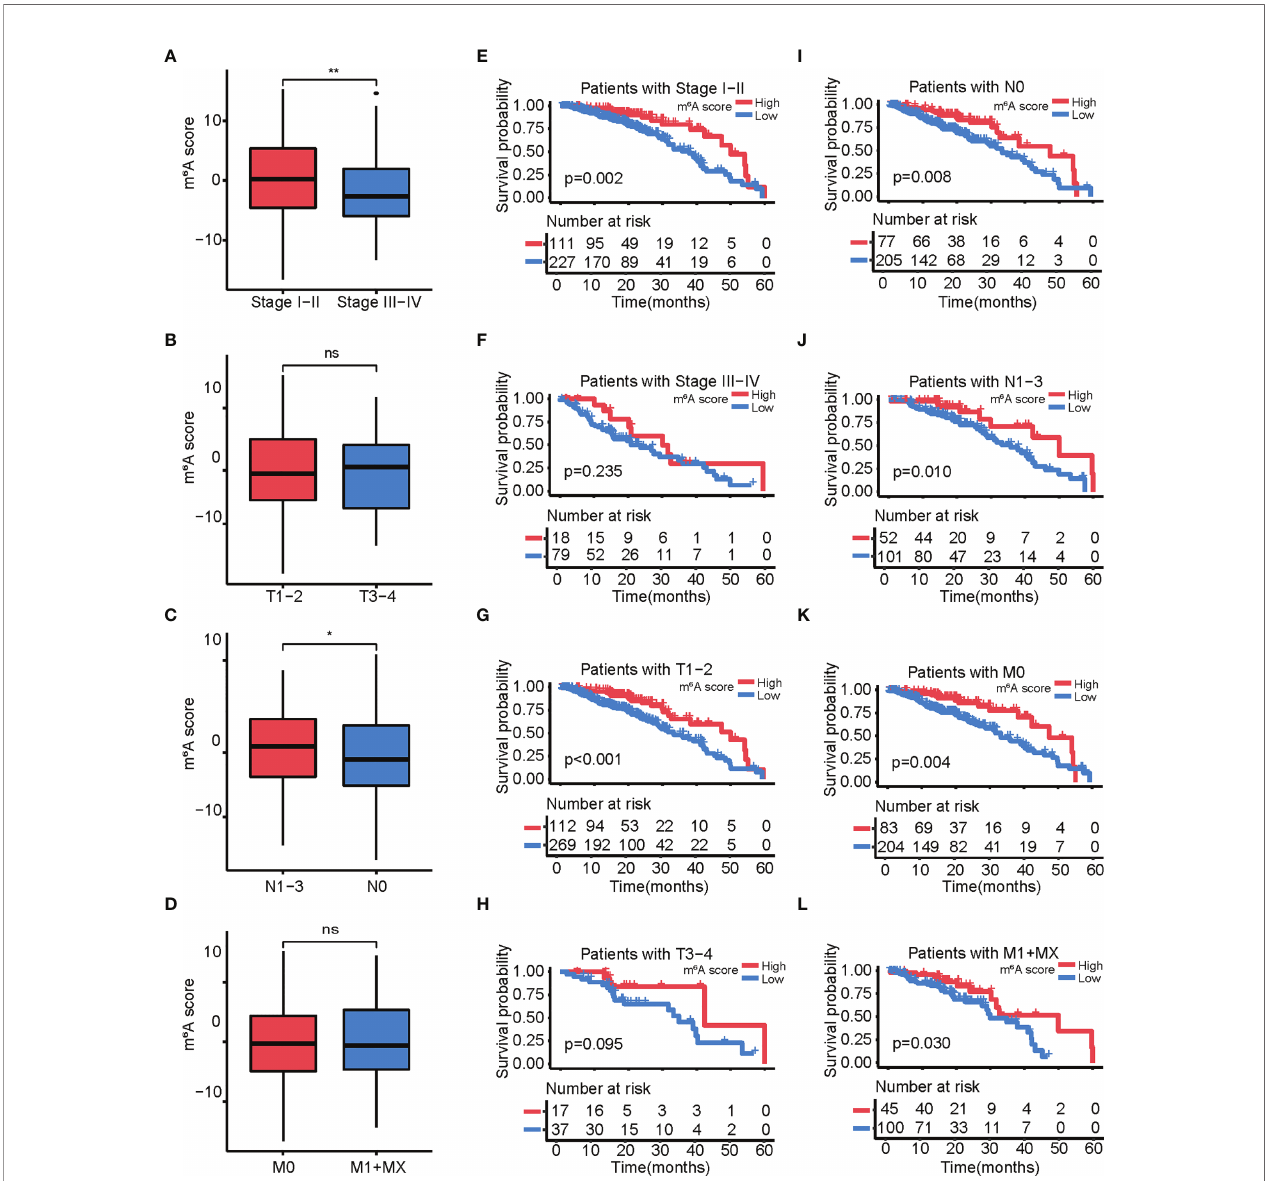
FIGURE 7 | Relationship between the m 6 A score and different clinical characteristics. (A − D) Box plot showing differences in m 6 A score among patients with different clinical characteristics. (A) Stages I – II vs. stages III – VI; (B) T 1 – 2 vs. T 3 – 4; (C) N 1 – 3 vs. N 0; (D) M 0 vs. M 1+X. (E − I) Kaplan-Meier curves showing the differences in survival depending on the m 6 A score and different clinical characteristics. (E) Stages I – II. (F) Stages III – VI; (G) T 1 – 2; (F) T 3 – 4; (I) N 0; (J) N 1 – 3; (K) M 0; (L) M 1+X. The asterisks represented the statistical p-value (ns p > 0.05; * p <0.05; ** p <